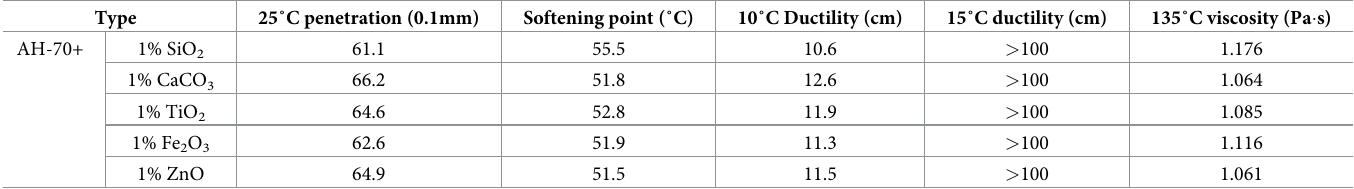
Table 3. Technical properties of modified asphalt binders with different nano-particles.